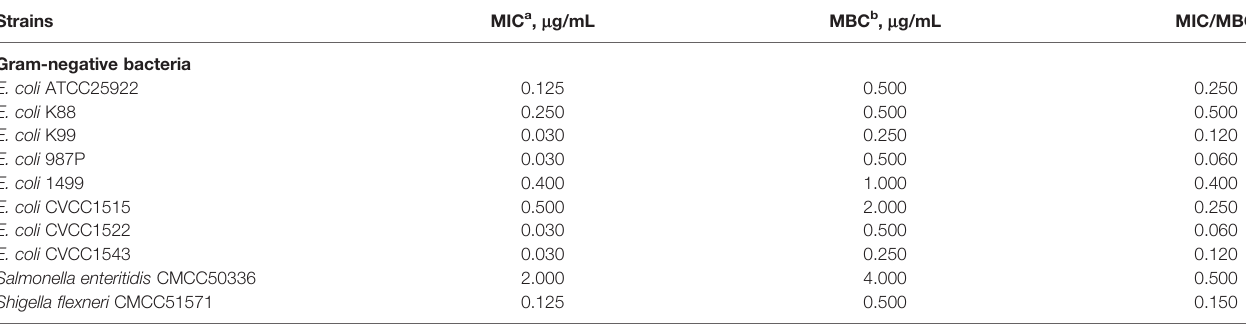
TABLE 1 | MIC and MBC comparison of antimicrobial peptide MccJ25 among standard pathogens. Strains